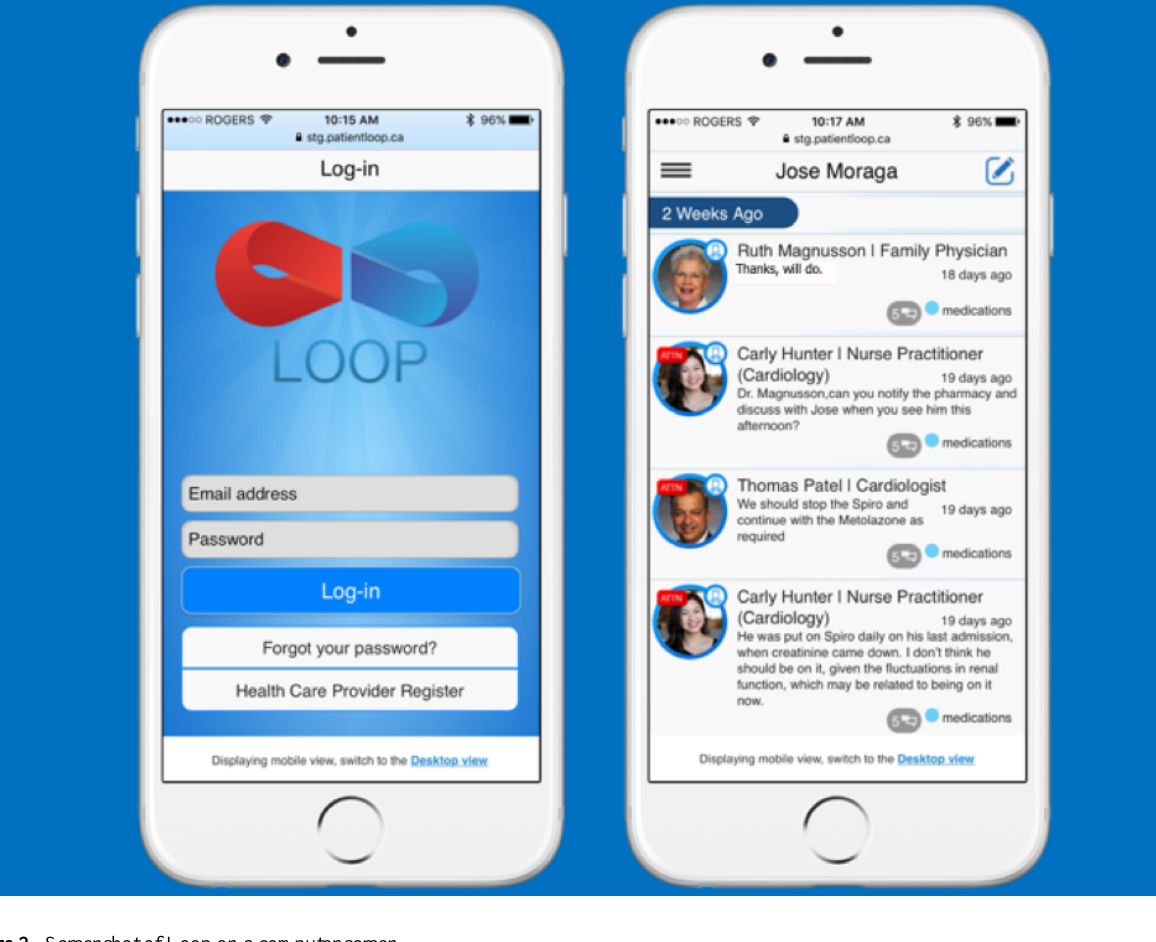
Figure 2. Screenshot of Loop on a computer